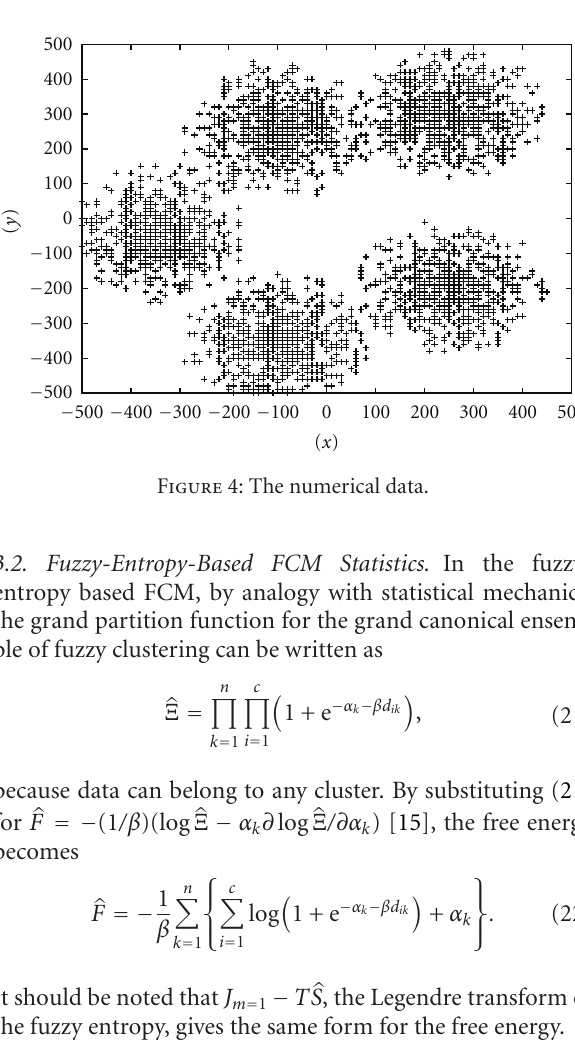
Figure 3: The plots of the cooling functions of (a) proportional to an exponential ( r = 0 . 1,1,10) and (b) very fast annealing methods ( m = 1 . 0,2 . 0,3 . 0).